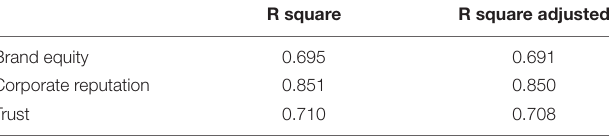
TABLE 4 | Cross loading.